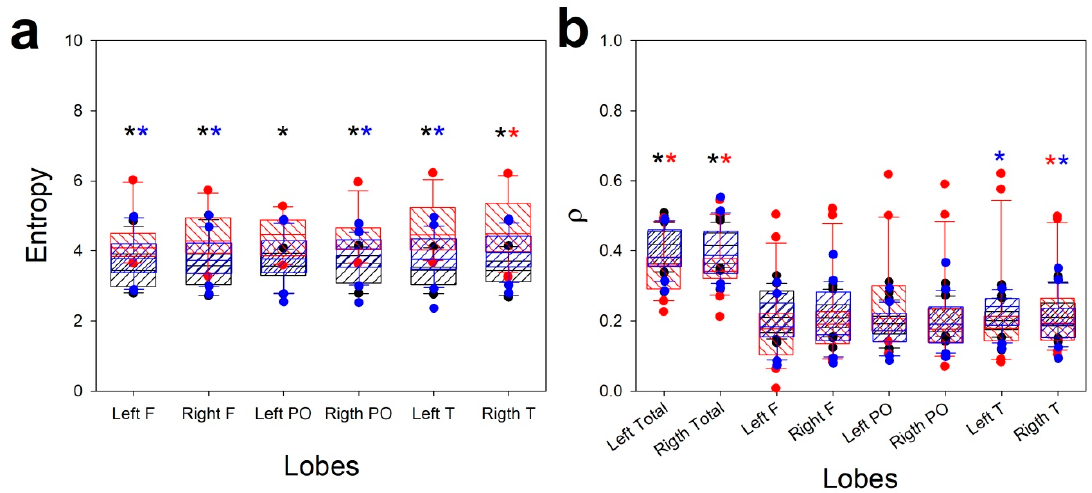
Figure 4. Box plots showing comparison of the structure of entropy and synchronization for different groups: ( a ) Se; ( b ) p . Striped black box: ECN; striped red box, COVID; striped blue box, CRA; black asterisk: difference between ENC and COVID; red asterisk: difference between ENC and CRA; blue asterisk: difference between COVID and CRA.